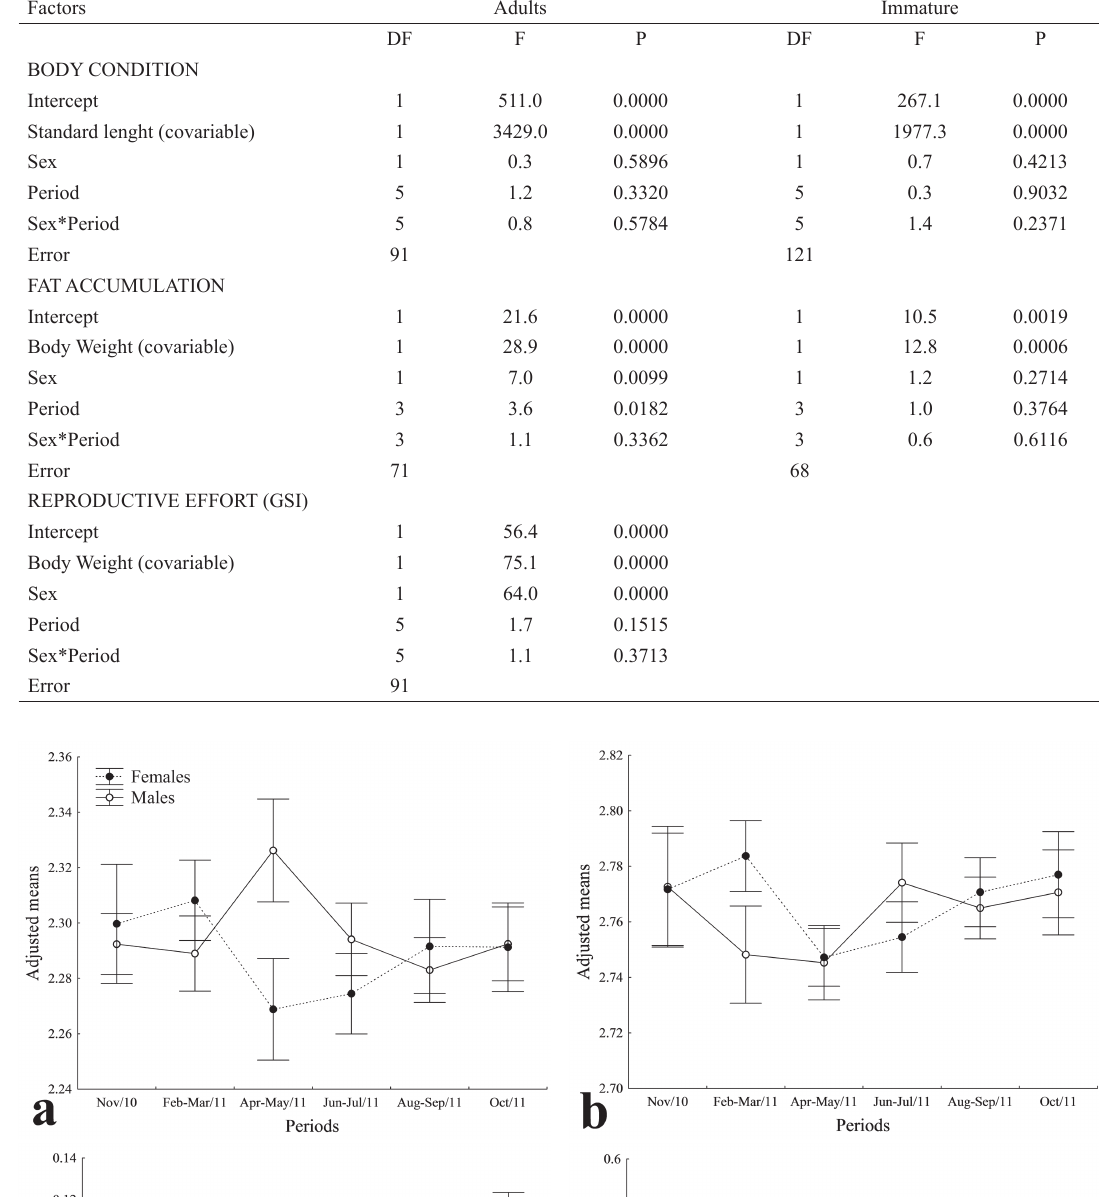
Table 4. Analysis of covariance (Ancova) testing variations in body condition (body weight, g), fat accumulation (g) and reproductive effort (GSI) among sexes, periods and the interaction sex*period (categorical